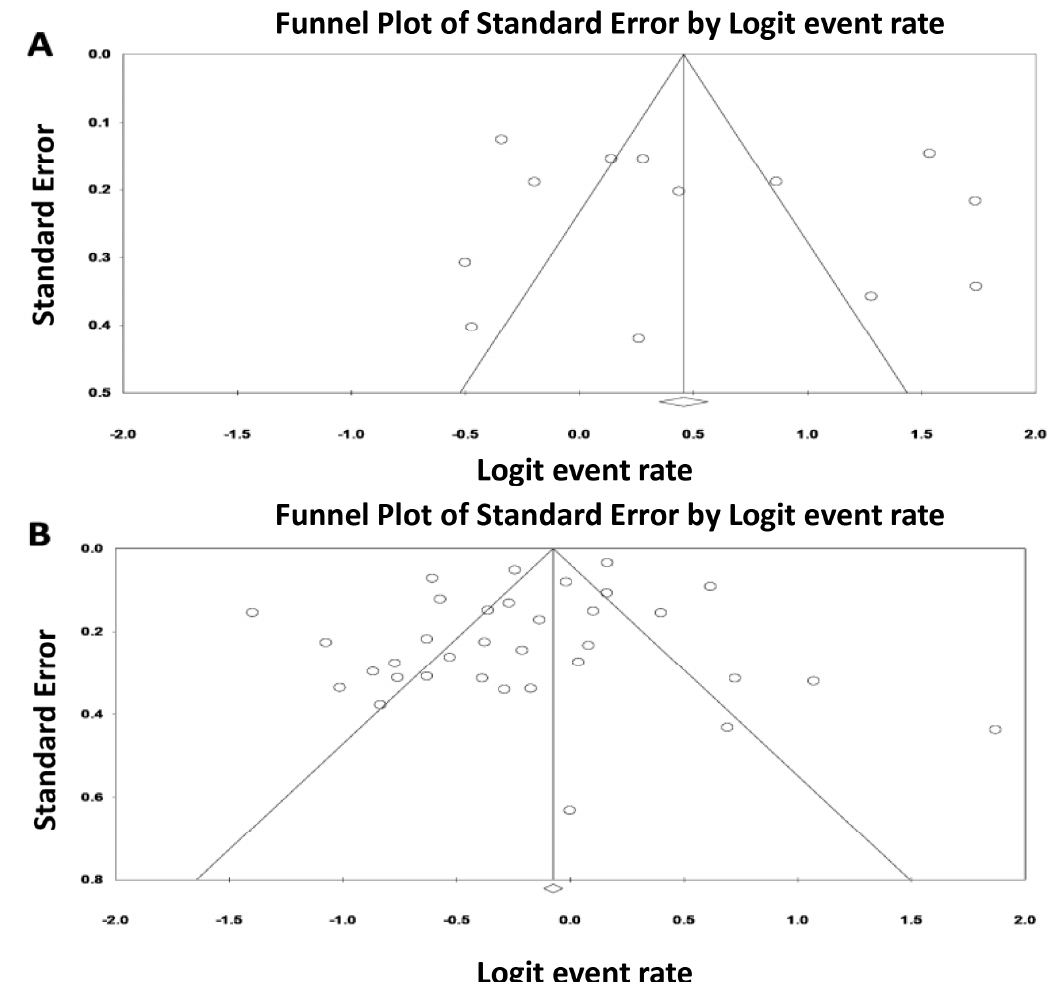
Figure 7. Funnel plot demonstrated no publication bias in analyses evaluating ( A ) incidence of AKI in patients requiring ECMO and ( B ) severe AKI requiring RRT.